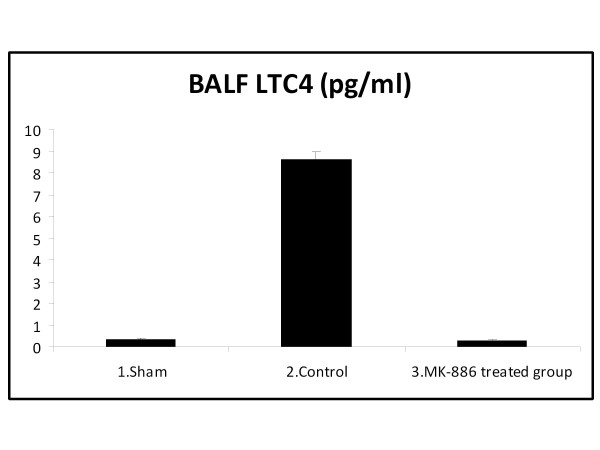
The mean of BALF LTC4 level (pg/ml) in the three experimental groups at the end of the experiment.